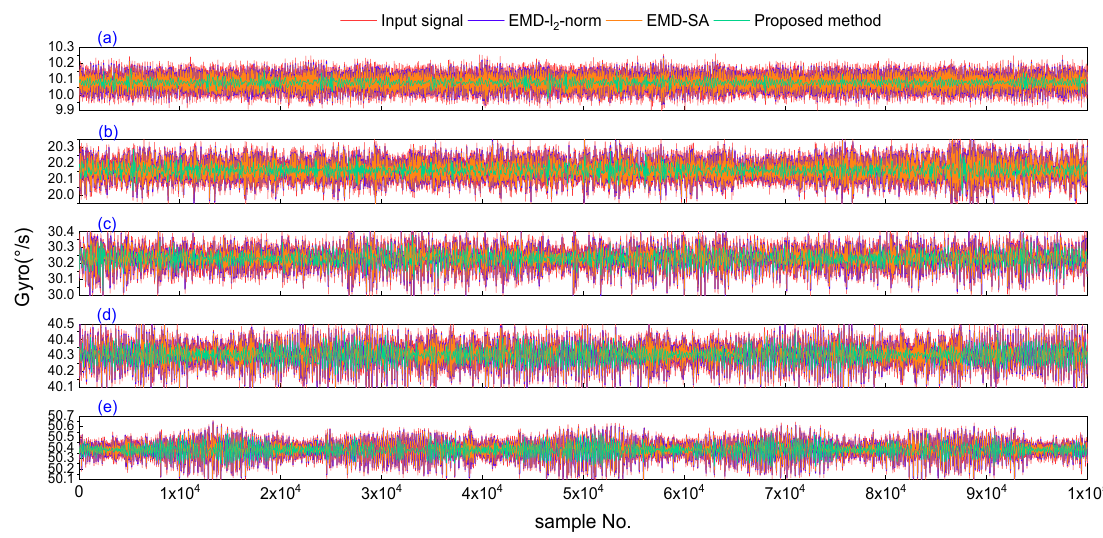
Figure 9. The gyroscope dynamic signal and its denoised results for three denoising methods in the five dynamic tests. The red line is the gyroscope’s dynamic signal; the blue, orange, and green lines are the denoising results of the EMD- l 2 -norm, EMD-SA, and the proposed method, respectively. ( a – e ) Dynamic gyroscope signals and the denoised results for the three denoising methods, with speeds of 10 °/s, 20 °/s, 30 °/s, 40 °/s, and 50 °/s, respectively.